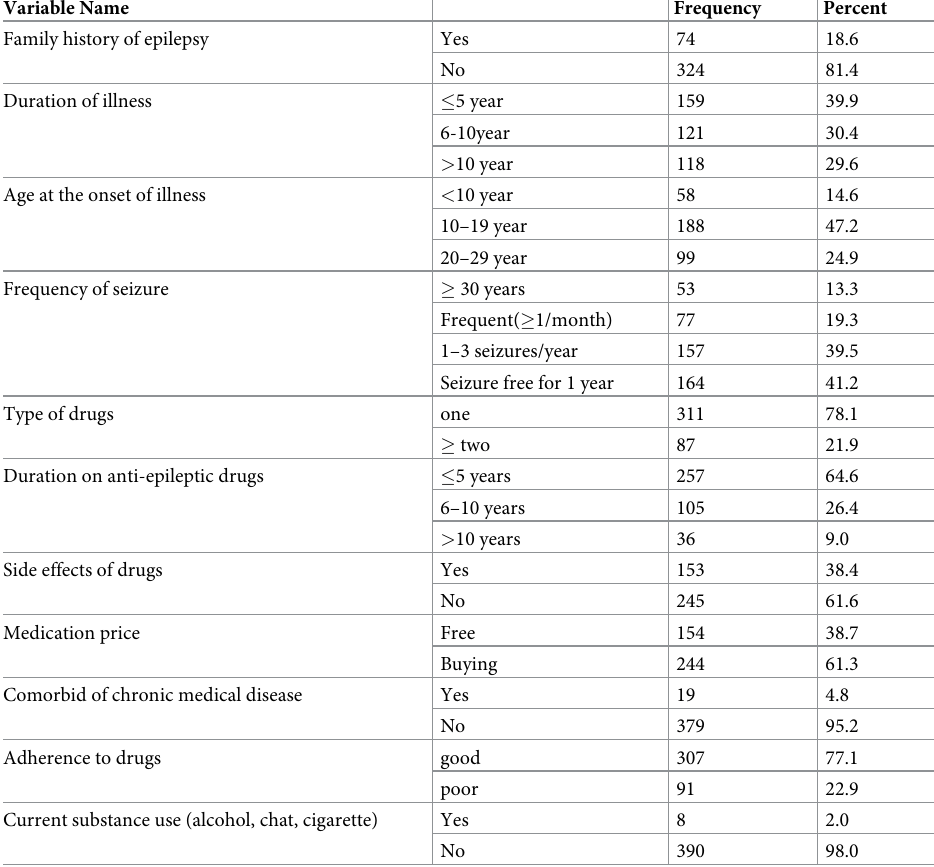
Table 2. Distribution of people living with epilepsy by their clinical status at government health institutions in Bahir Dar City, 2017(n =